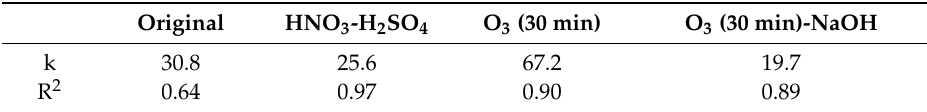
Table 5. Gage factors (k) and Pearson’s correlation coefficients in the sensing function of CNTs pastes with different oxidation treatments.